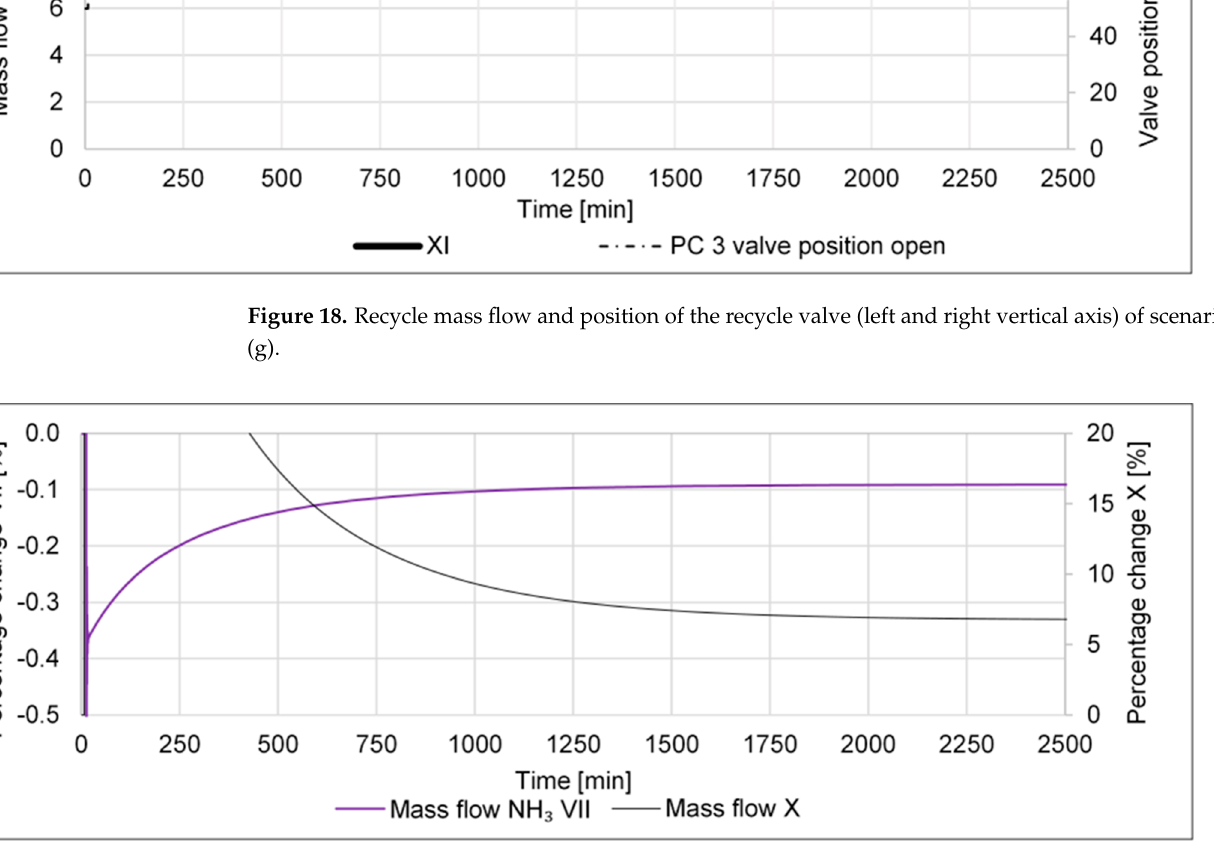
Figure 19 . Percentage change of mass fl ows NH3 VII and X (left and right vertical axis) of scenario Figure 19. Percentage change of mass flows NH3 VII and X (left and right vertical axis) of scenario (g).